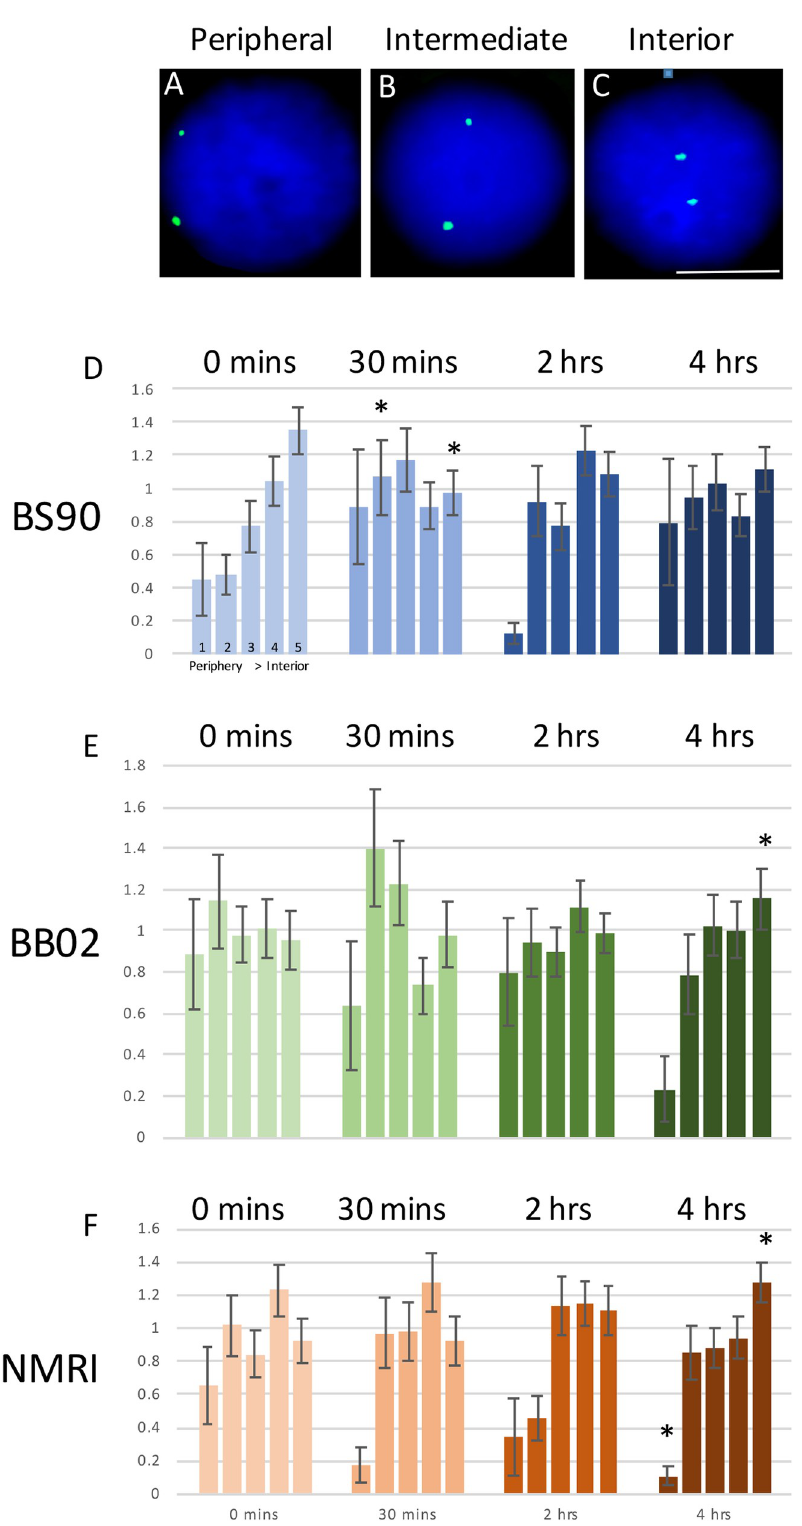
Fig 14. Nuclei, in blue, as they are stained with DAPI, were isolated from snail strains BS90, BB02 and NIMR ovo- testis and subjected to 2D-fluorescence in situ hybridisation (FISH) with fluorescein labelled probes for the transposable element, piwi (green). Panel A displays a peripheral nuclear location, panel B an intermediate